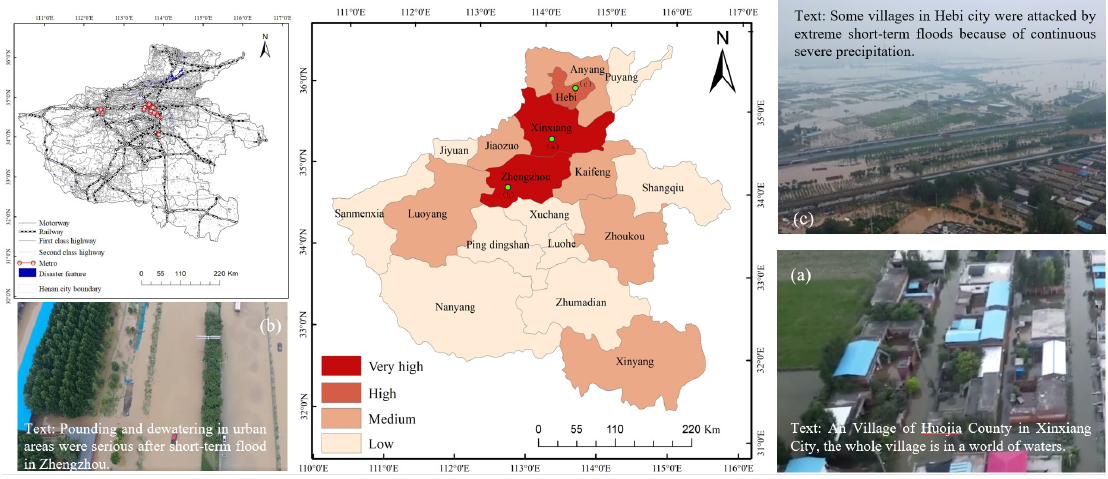
Figure 8. The severity of short-term flood disasters based on social media data.